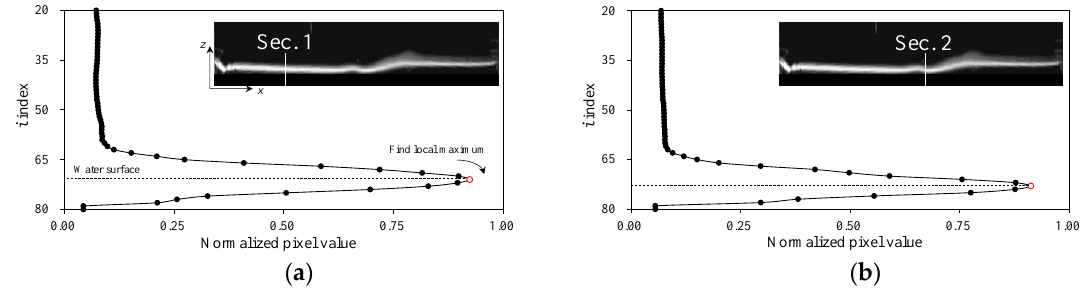
Figure 6. Inundation depth measurements using the laser image: ( a ) Sec. 1; ( b ) Sec. 2.